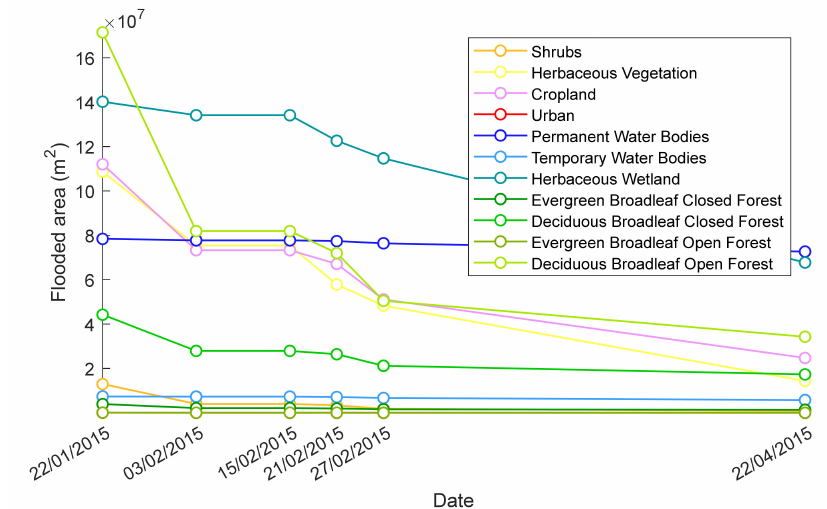
Figure 3. Estimation of the areas flooded for each CORINE land cover class, in the sequence of Sentinel-1 images. Colors in the legend follow the standard CORINE class labels shown in Figure